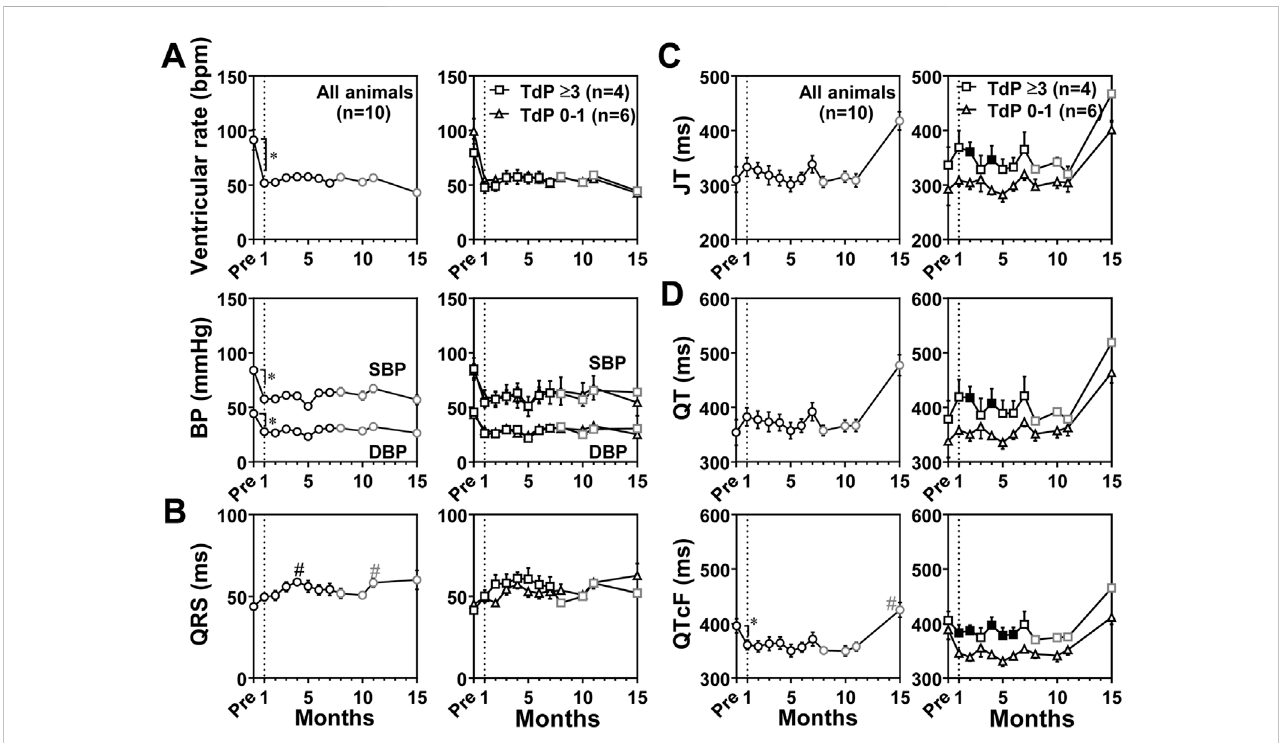
FIGURE 4 Time courses of changes in the ventricular rate and systolic/diastolic blood pressures (SBP/DBP) (BP) (A) and electrocardiographic variables including QRS width (QRS) (B) , JT interval (JT) (C) , and QT interval (QT) and QT interval corrected by Fridericia ’ s formula (QTcF) (D) under anesthesia. The diagram structure and de fi nitions of abbreviations are the same as in Figure 3. Data are presented as mean ± s.e.m. * p < .05, before atrioventricular block (Pre) vs. 1 month by Wilcoxon matched-pairs signed rank test; and # p < .05, vs. 1 month by Friedman test with Dunn ’ s multiple comparison test. Filled symbols indicate p < .05 vs. the animals showing TdP 0 – 1 at the same month by Mann-Whitney U